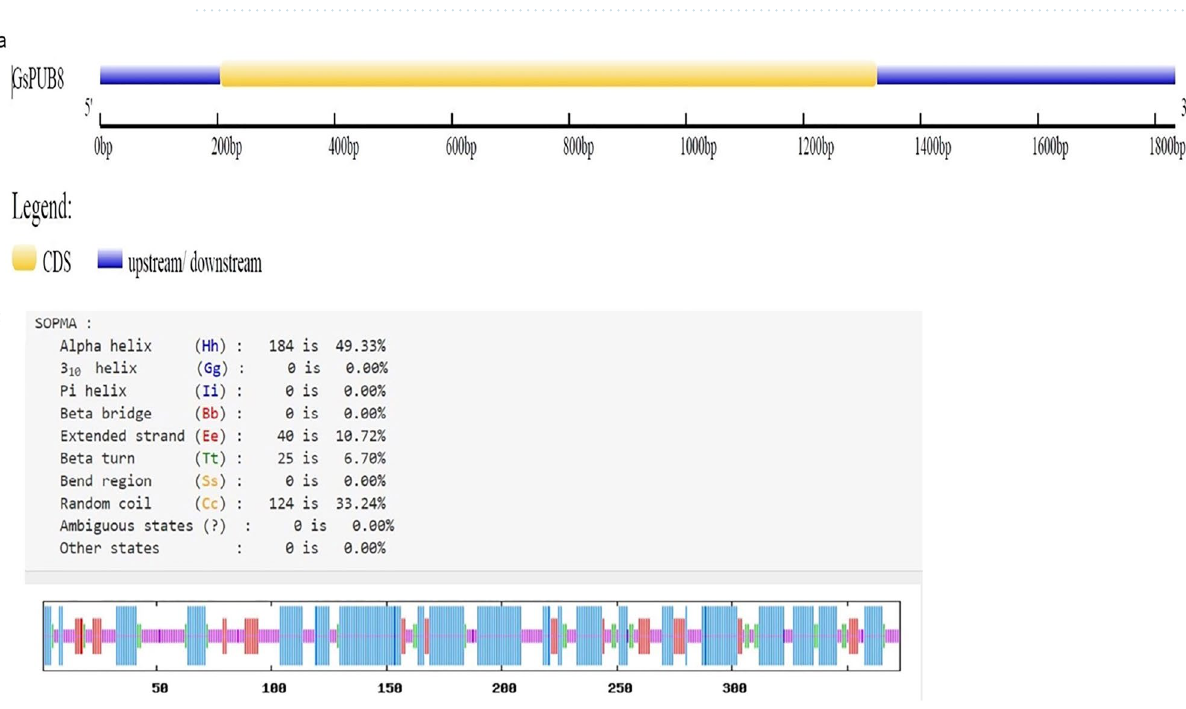
Figure 1. The sequence analysis of GsPUB8 protein. ( a ) The multiple sequence-alignment analysis of GsPUB8 amino acid sequences. ( b ) A phylogenetic tree highlighting close relationships among PUB8 protein from G. soja and other PUB8 proteins of monocots and dicots.